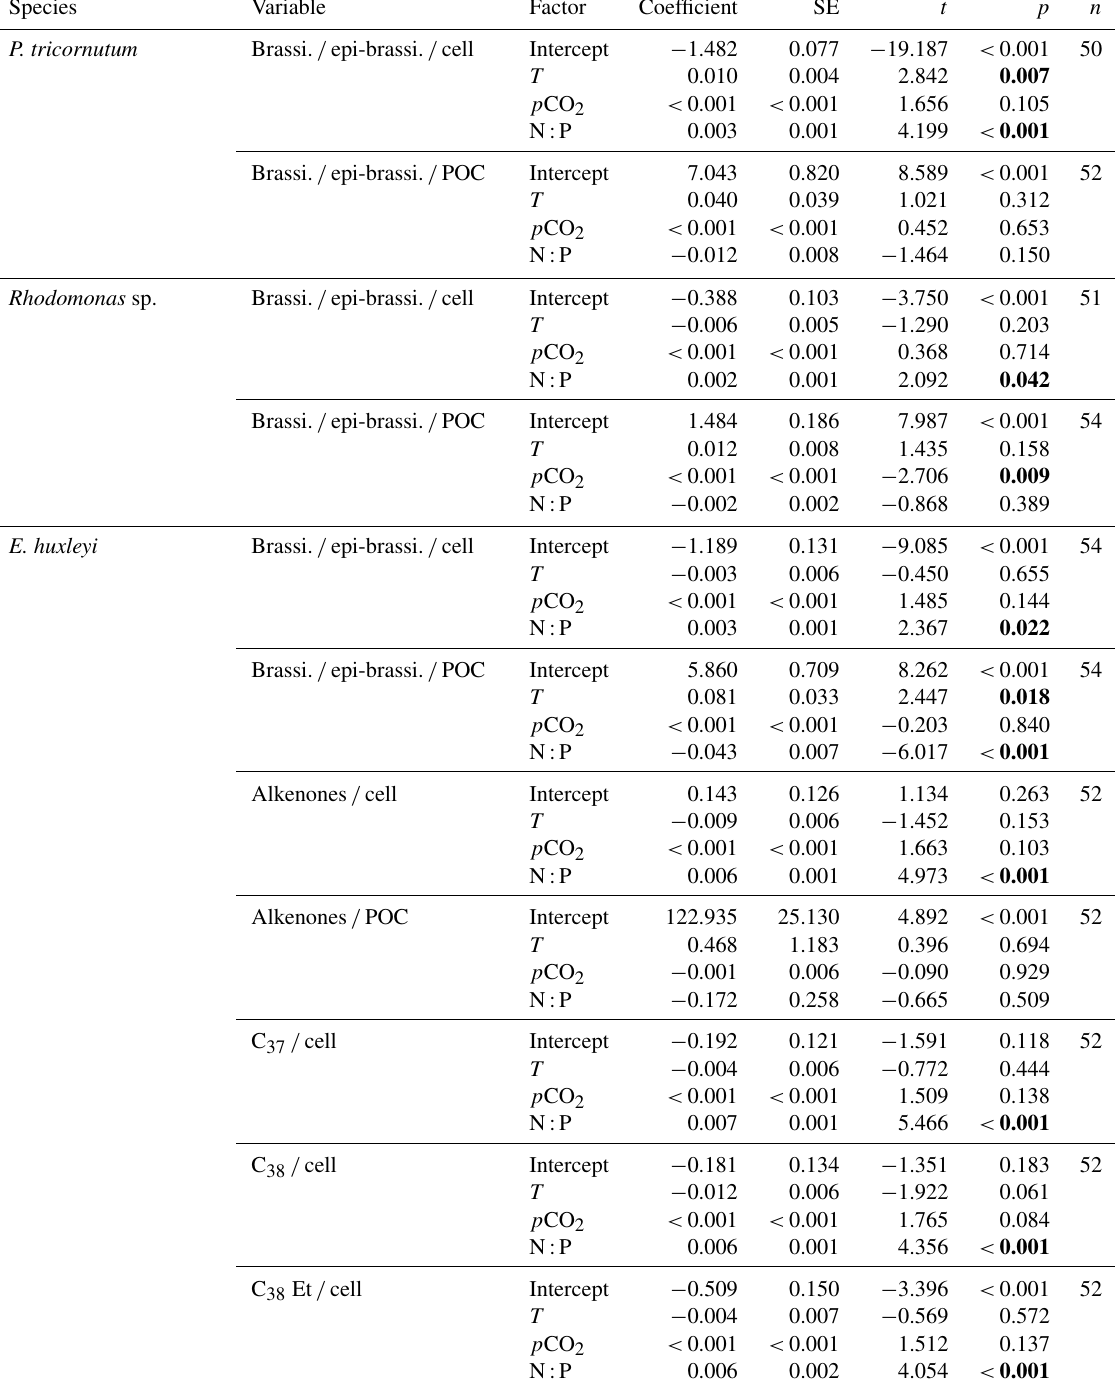
Table 1. Results of the selected GLMMs testing for the effects of temperature, N:P supply ratios and p CO 2 on carbon-normalized and per-cell contents of brassicasterol / epi-brassicasterol (brassi. / epi-brassi. / POC and brassi. / epi-brassi. / cell; µgmgC − 1 and pgcell − 1 ) in Phaeodactylum tricornutum , Rhodomonas sp. and Emiliania huxleyi ; carbon-normalized and per-cell contents of C 37 –C 39 total alkenones (Alkenones / POC and Alkenones / cell); per-cell contents of C 37 alkenones (C 37 / cell), C 38 alkenones (C 38 / cell), C 38 ethyl ketones (C 38 Et / cell) and C 38 methyl ketones (C 38 Me / cell); and the ratios of C 37 / C 38 alkenones and C 38 Et / C 38 Me (C 38 Et / Me) in E. huxleyi . Significant p values are shown in bold; T represents temperature, and N:P represents N to P supply ratios. Species Variable Factor Coefficient